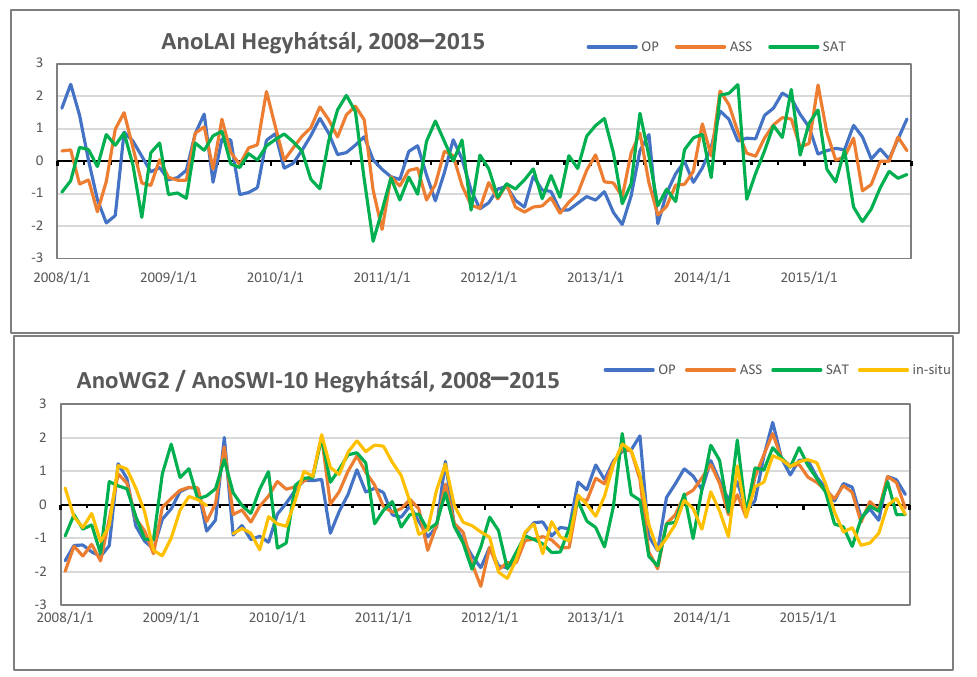
Figure 9. AnoLAI and AnoWG2/AnoSWI-10 time series for 2008–2015 at Hegyhátsál (OL: blue, ASS: orange, GEOV1 LAI and SWI-10: green, in-situ: yellow).